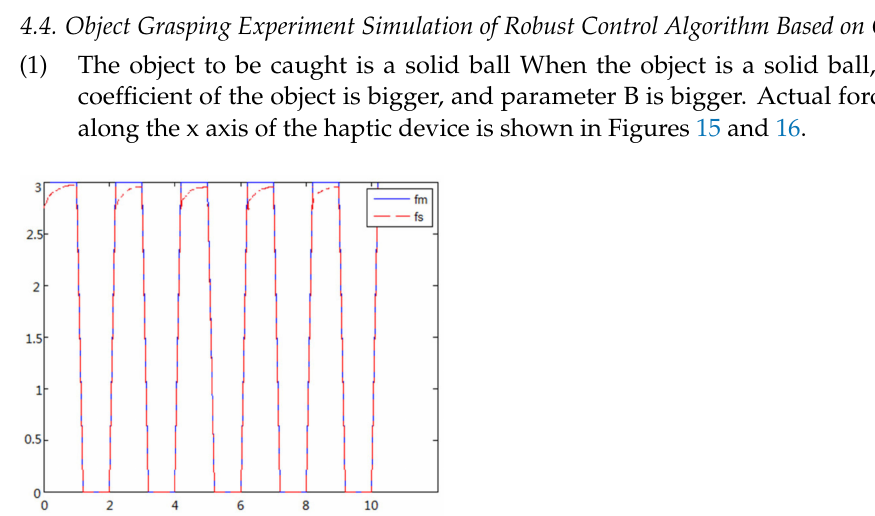
Figure 14. The trajectory tracking error of end effector, diagram of slave robot along x , y , z directions (robust control algorithm).